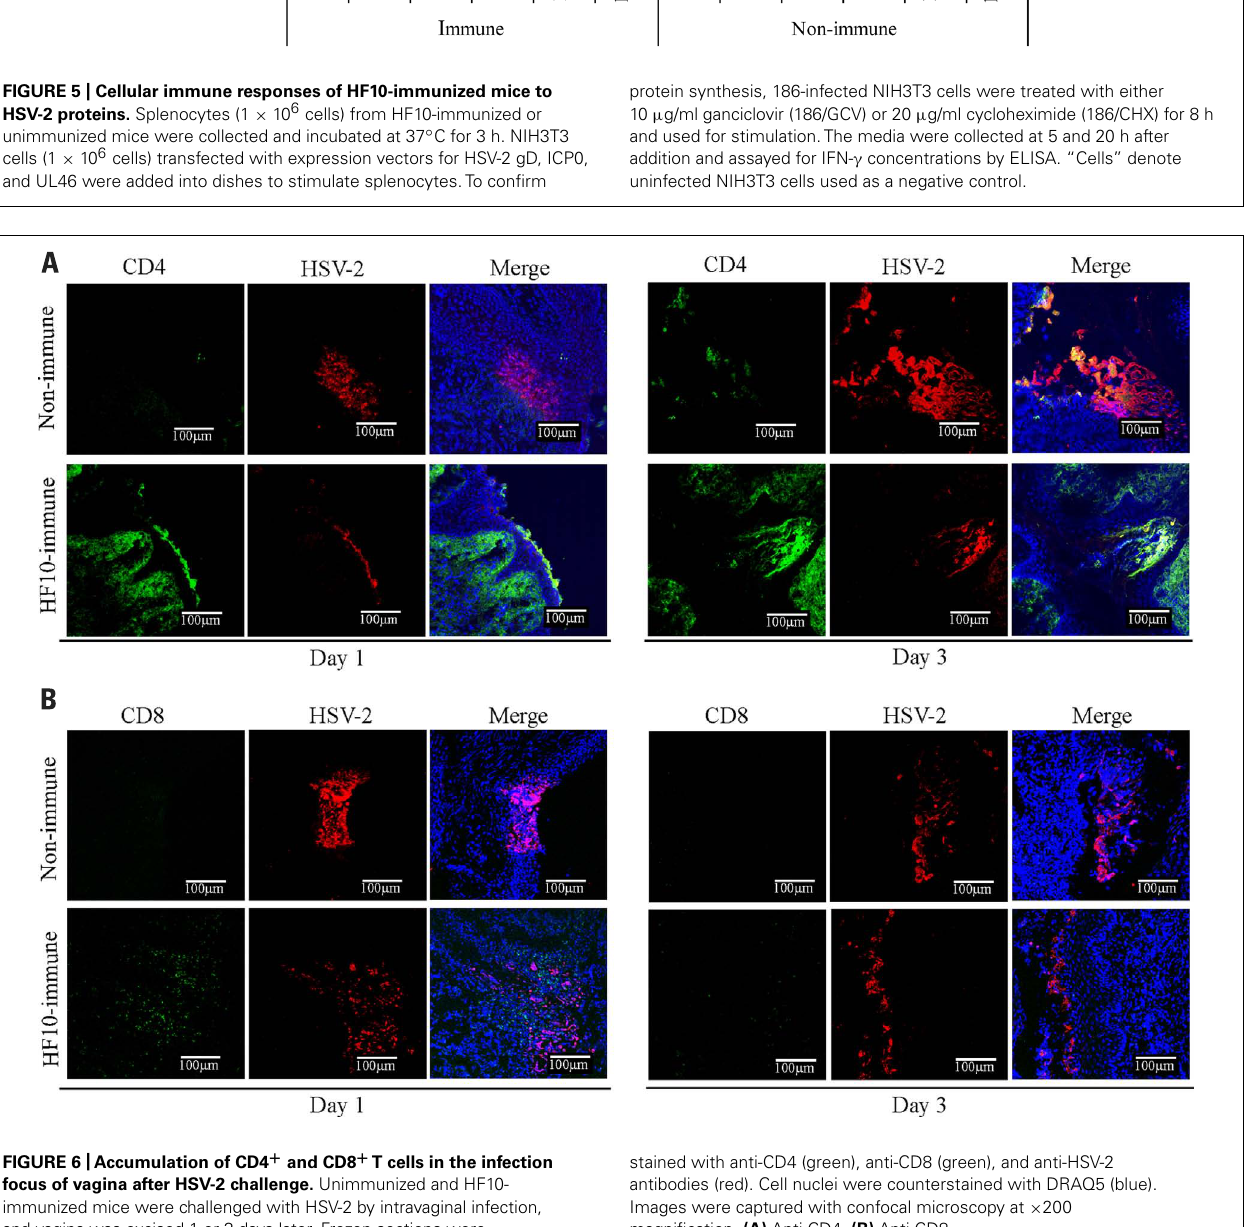
FIGURE 6 |Accumulation of CD4 + and CD8 + T cells in the infection focus of vagina after HSV-2 challenge. Unimmunized and HF10- immunized mice were challenged with HSV-2 by intravaginal infection, and vagina was excised 1 or 3 days later. Frozen sections were